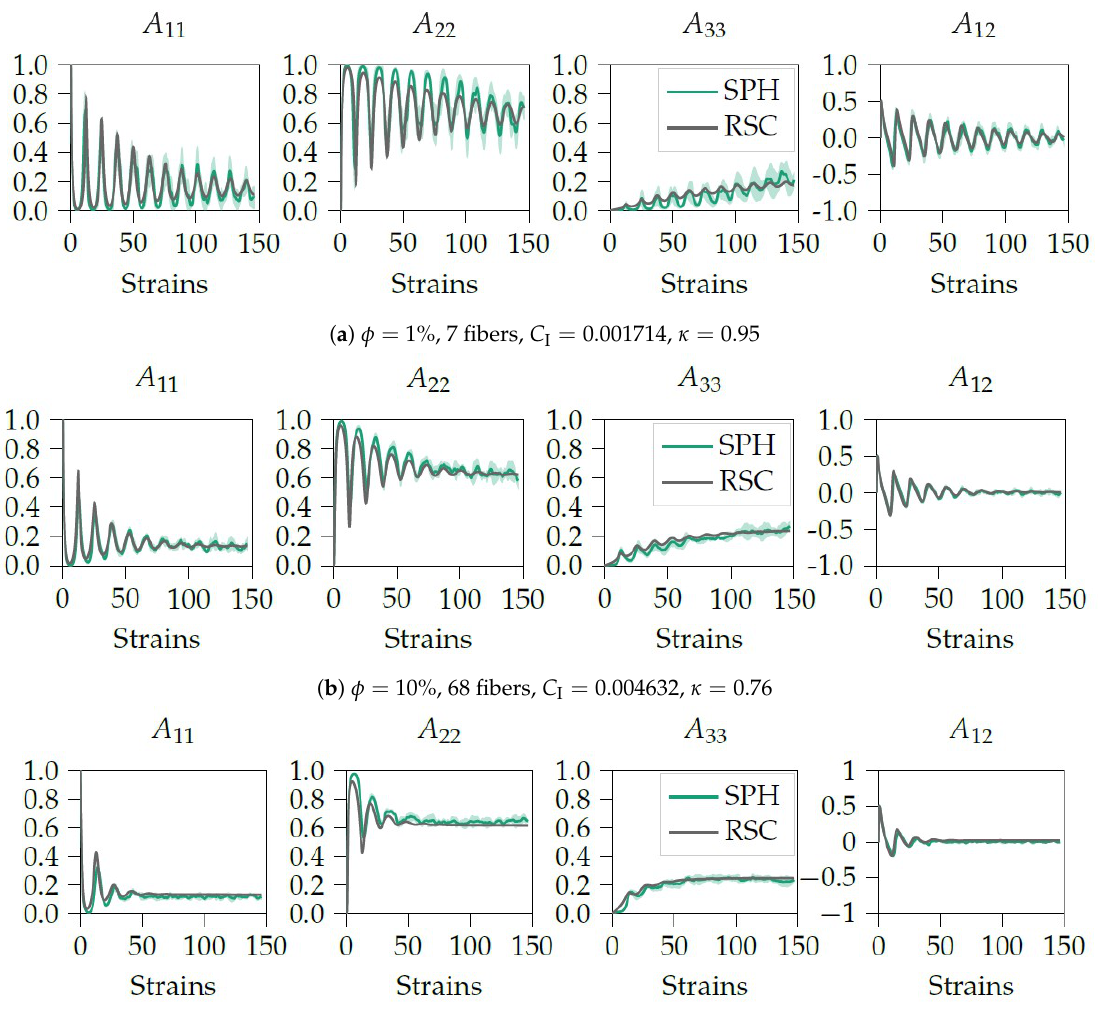
Figure 7. Ensemble average of fiber orientation tensor components for fibers with aspect ratio r p = 4.43 ( L f = 5) in a 3D shear flow and its comparison to the reduced strain model with optimal parameters. Each simulation result was obtained from five independently sampled initial configurations. The standard deviation is indicated by a light green filled area for each volume